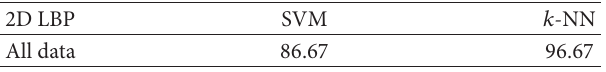
Table 13: The performance of classifiers for VSVL model when the 2D LBP scheme is used for feature extraction. 2D LBP